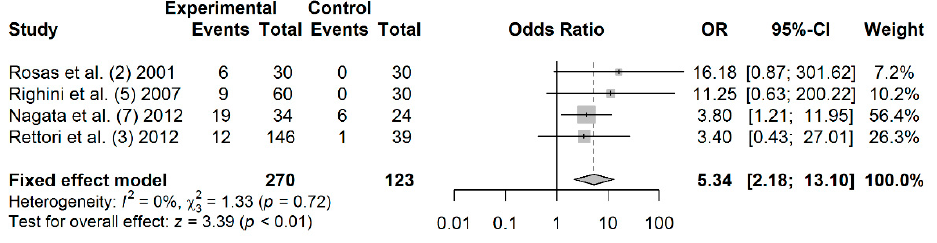
Figure 4. Forest plot for the association between DAPK promoter hypermethylation and HNC risk. The squares represent the ORs for individual studies. Bars represent the 95% CIs. The center of the diamond represents the summary effect size.